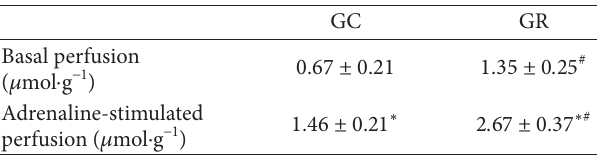
Table 3: AUCs for the liver release of glucose in the fasted state after an acute exercise session.